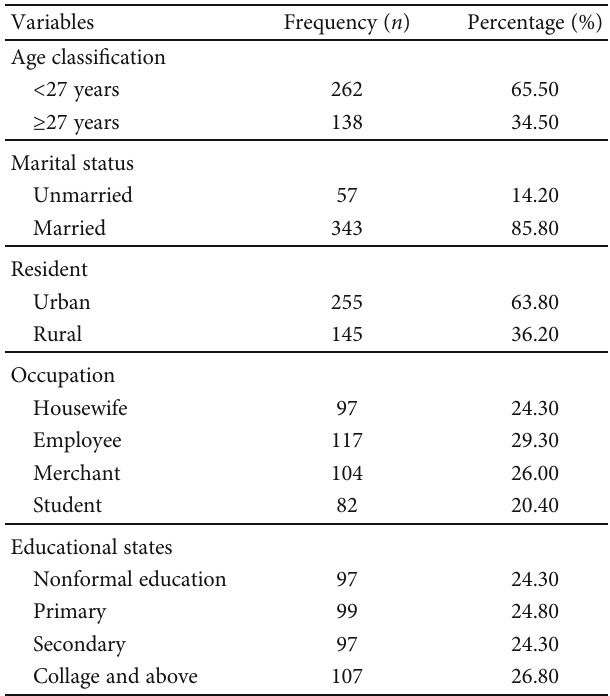
Table 1: Sociodemographic characteristics of respondents on magnitude and factors of episiotomy in Arba Minch General Hospital, Southern